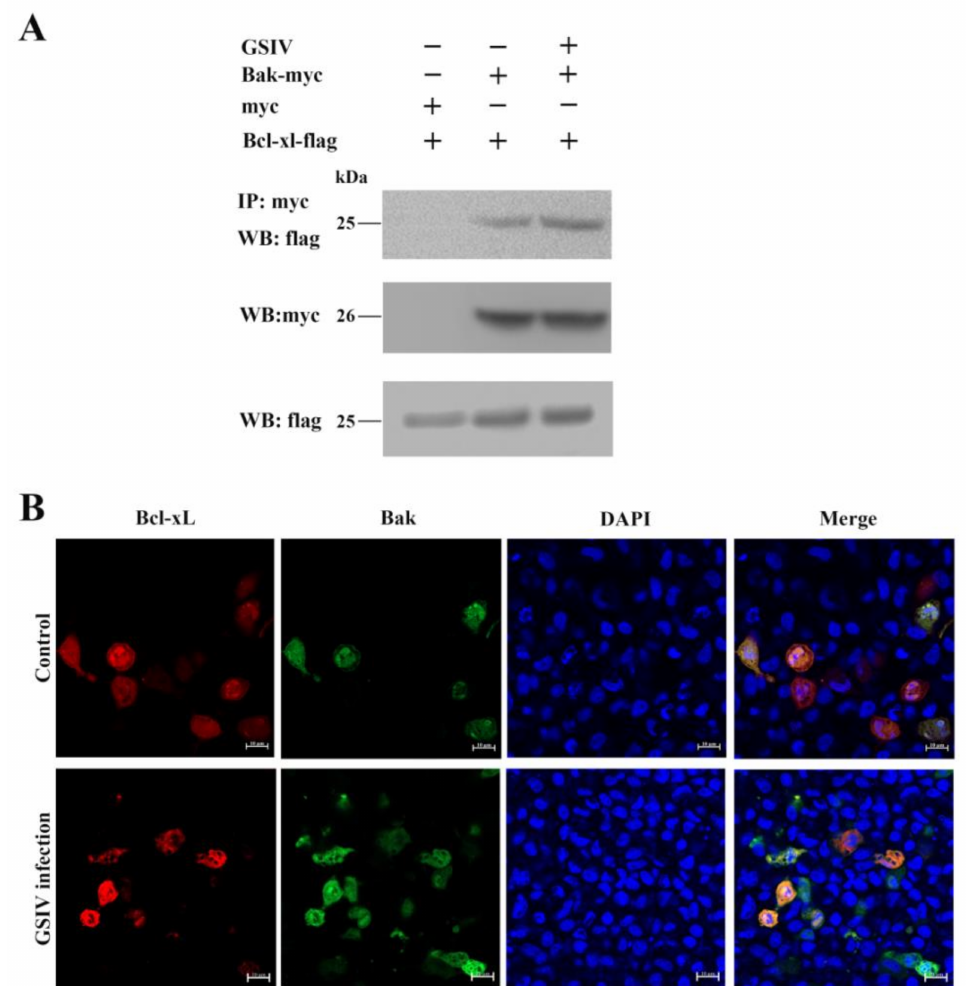
Figure 6. Interactions of Chinese giant salamander Bcl-xL and the proapoptotic protein Bak. ( A ) pCDNA3.1-flag-Bcl-xL and pCDNA3.1-myc-His-Bak or pCDNA3.1-myc-His were co- overexpressed in GSM cells, with or without GSIV infection, and interactions determined by coim- munoprecipitation assays using anti-Myc antibodies. ( Top ) anti-Myc pulldown, Western blotting using anti-Flag antibody; ( Middle ) Western blotting using anti-Myc antibodies; ( Bottom ) Western blotting using anti-Flag antibodies. ( B ) pDsRed-Monomer-N1-Bcl-xL and pEGFP-N1-Bak were co- overexpressed in GSM cells, with or without GSIV infection, and interactions were determined using confocal microscopy. Scale bar, 10 µ